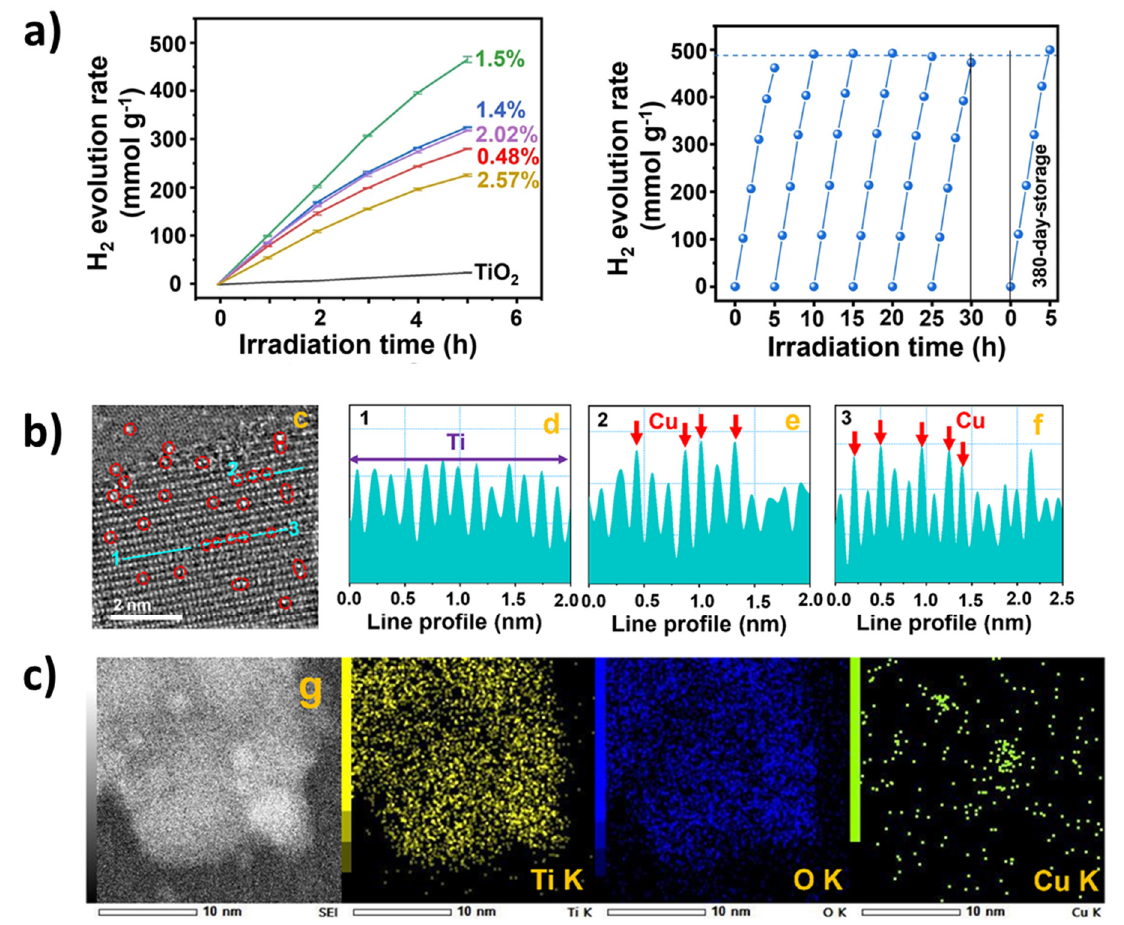
Figure 6. ( a ) The photocatalytic H 2 evolution rate of TiO 2 loaded with different ratios of Cu SA catalysts as a function of the irradiation time (left side) and right side—the photocatalytic activity of the ca. 1.5 wt% CuSA-TiO 2 for six cyclic water splitting experiments and the last run is the activity of the sample after storing in the lab for 380 days, ( b ) filtered HAADF STEM image and the corresponding line scan profiles, ( c ) STEM-EDS mapping of Ti, O, and Cu of the fresh CuSA–TiO 2 . With permission from Ref [116], Copyright © 2021 ,Springer Nature.